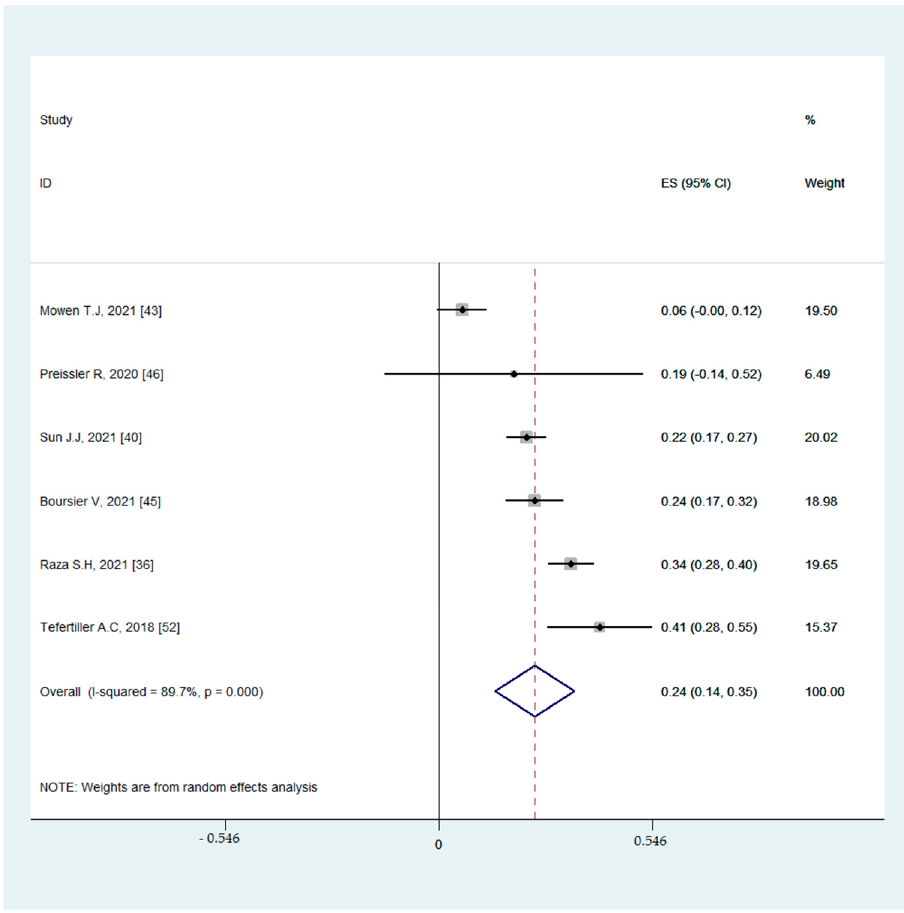
Figure 6. The forest plot displaying the estimated pooled Fisher’s z-score in the association between binge-watching and anxiety.